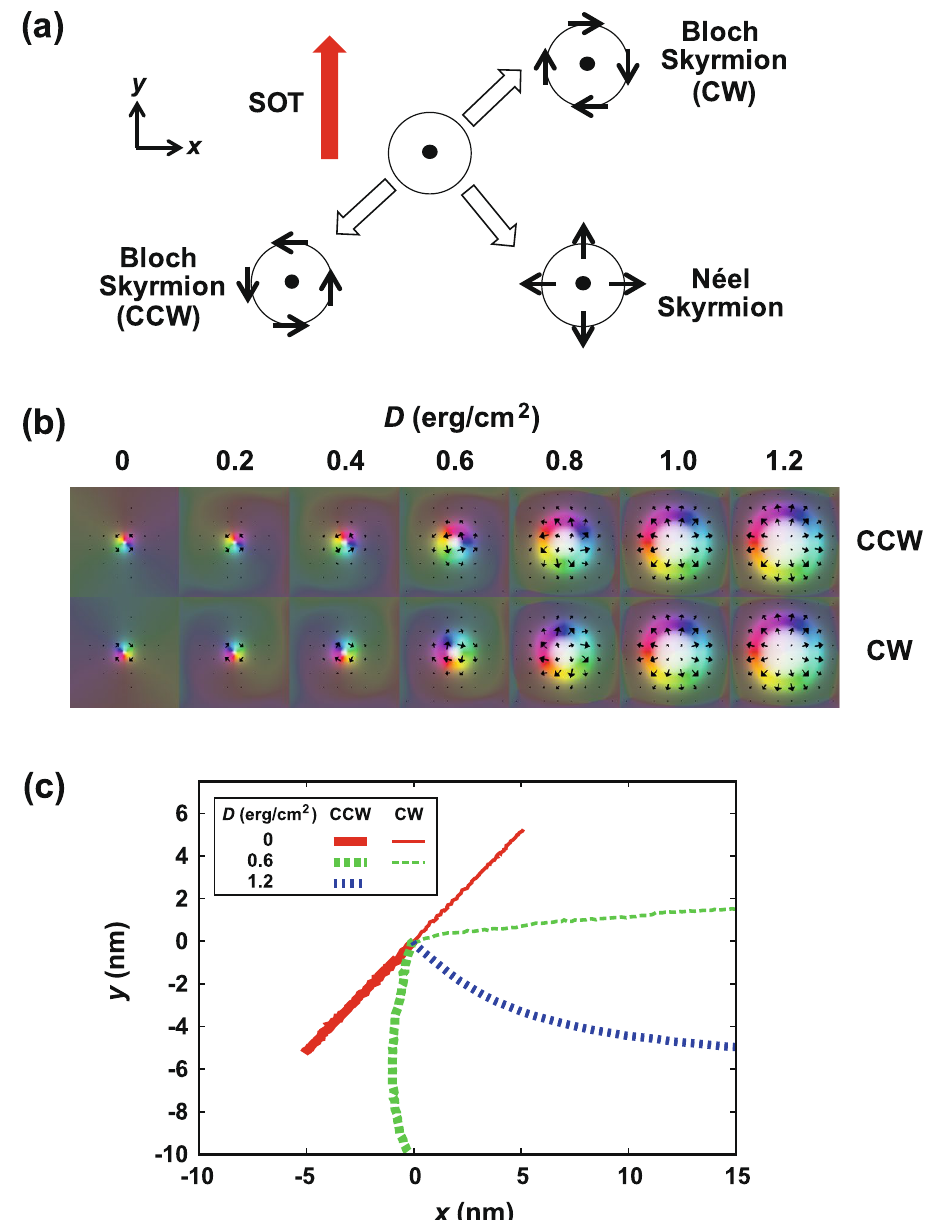
Figure 1. Motion of a skyrmion by SOT. ( a ) Direction of a motion of Bloch type skyrmions (CW and CCW) and Néel type skyrmion by SOT (analytical result 31 ). ( b ) Change of the skyrmion structures for CCW and CW by the D value. (c) Change of the motion direction of a skyrmions for CCW and CW by the D value (simulation